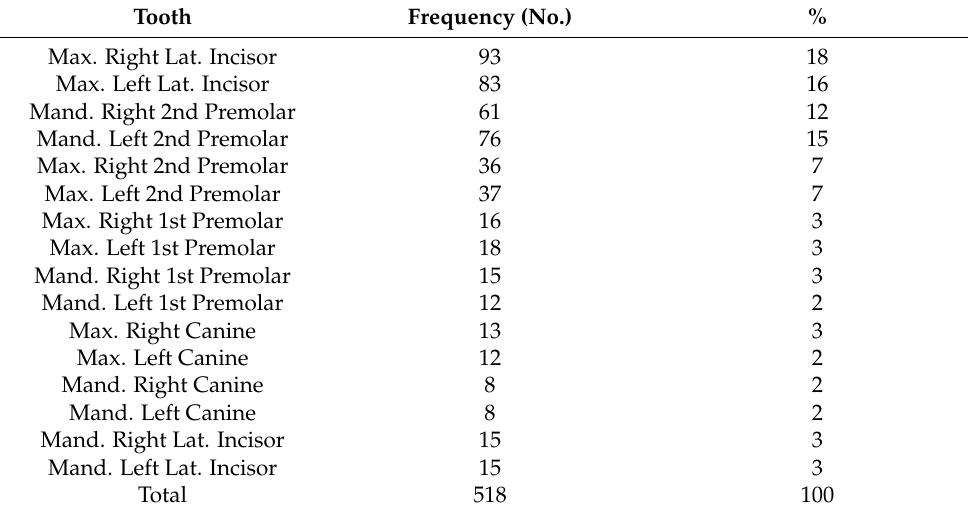
Table 3. Distribution of missing teeth by location.